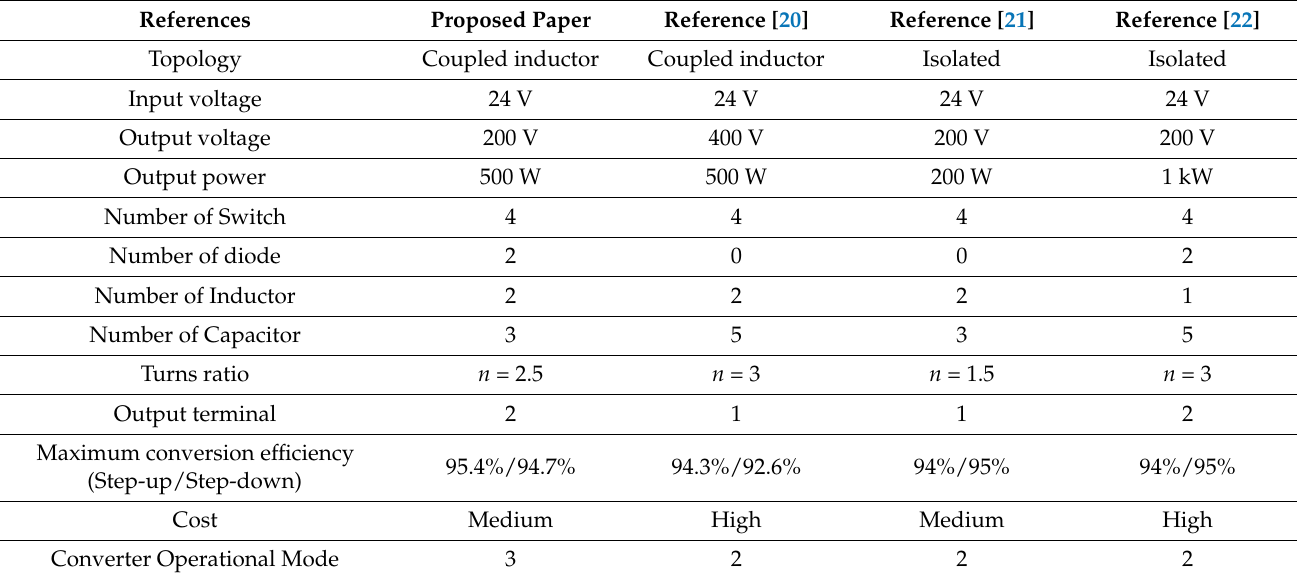
Table 1. Comparison of the proposed converter with other presented bidirectional